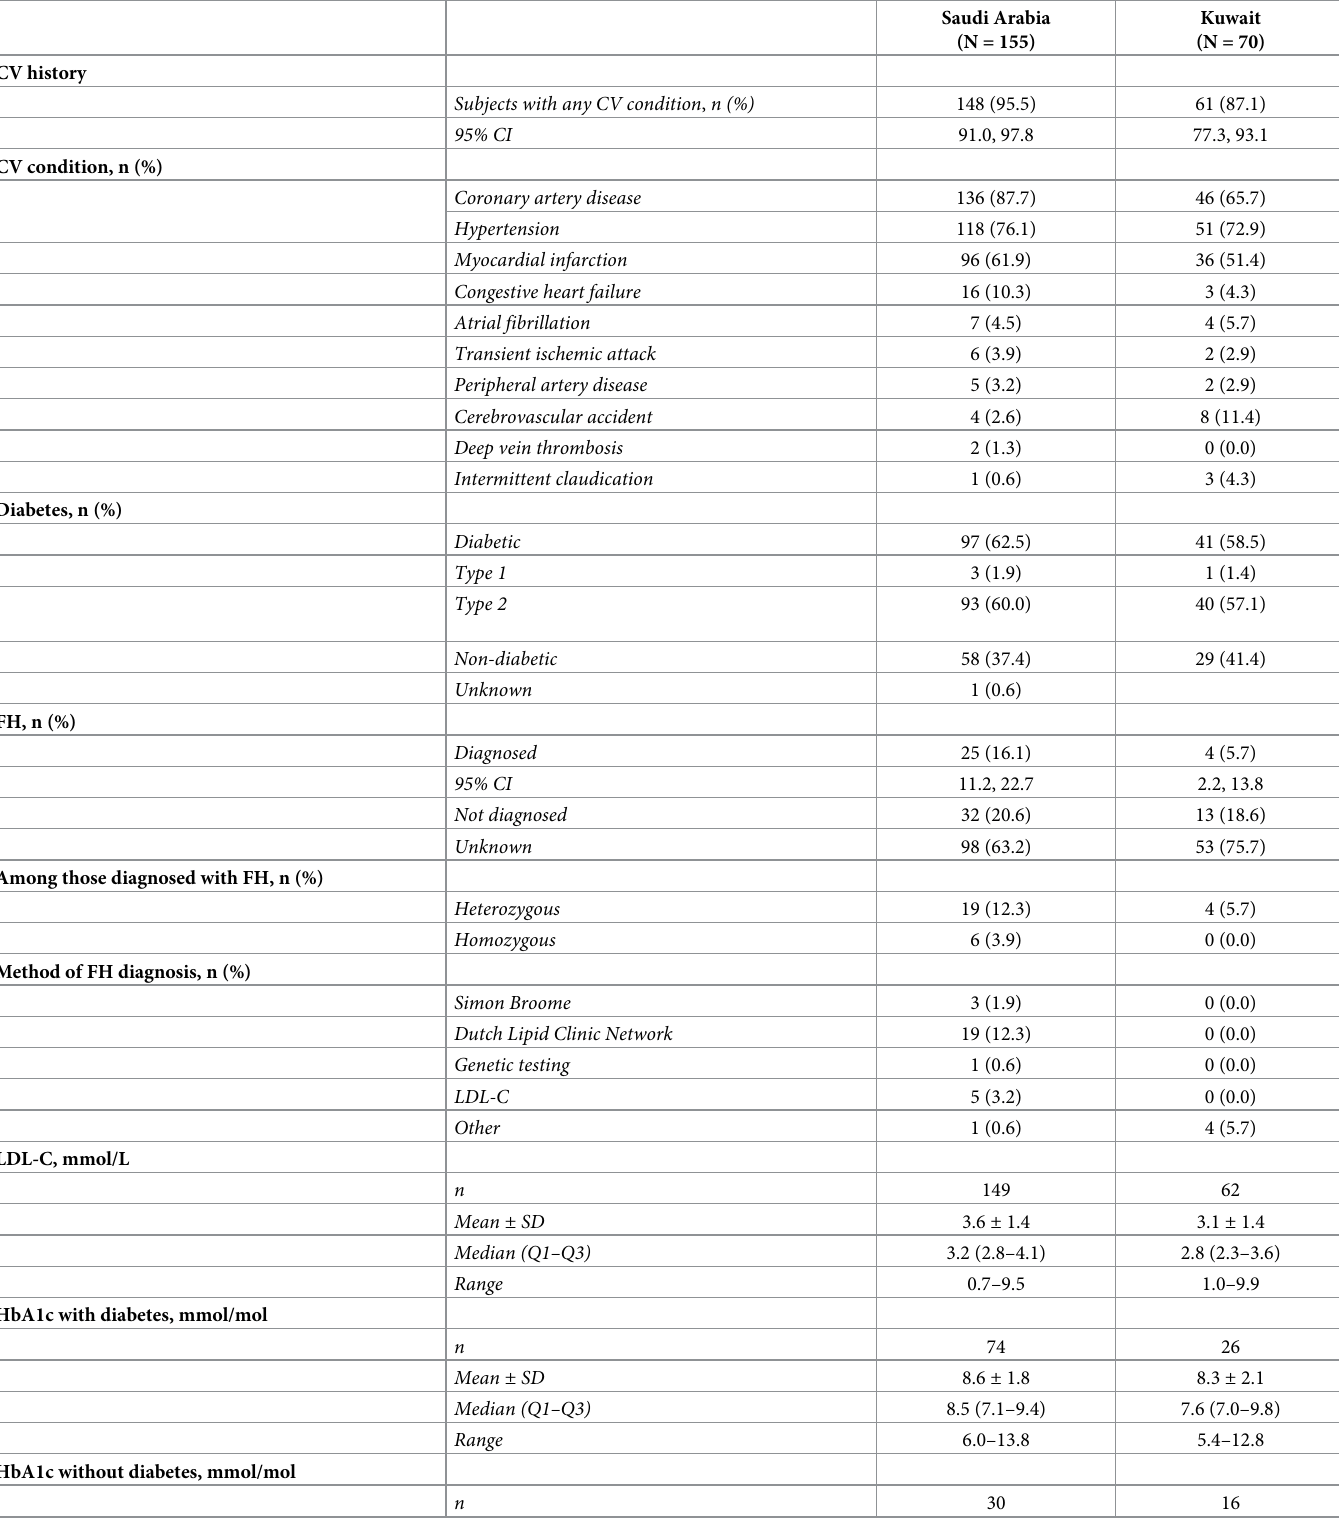
Table 2. Baseline characteristics of patients in Saudi Arabia and